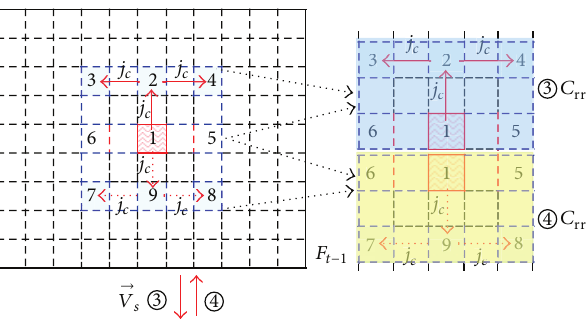
Figure 8: Schematic diagram of 𝐶 Table 2: Position coordinates of vertex macroblocks with horizontal